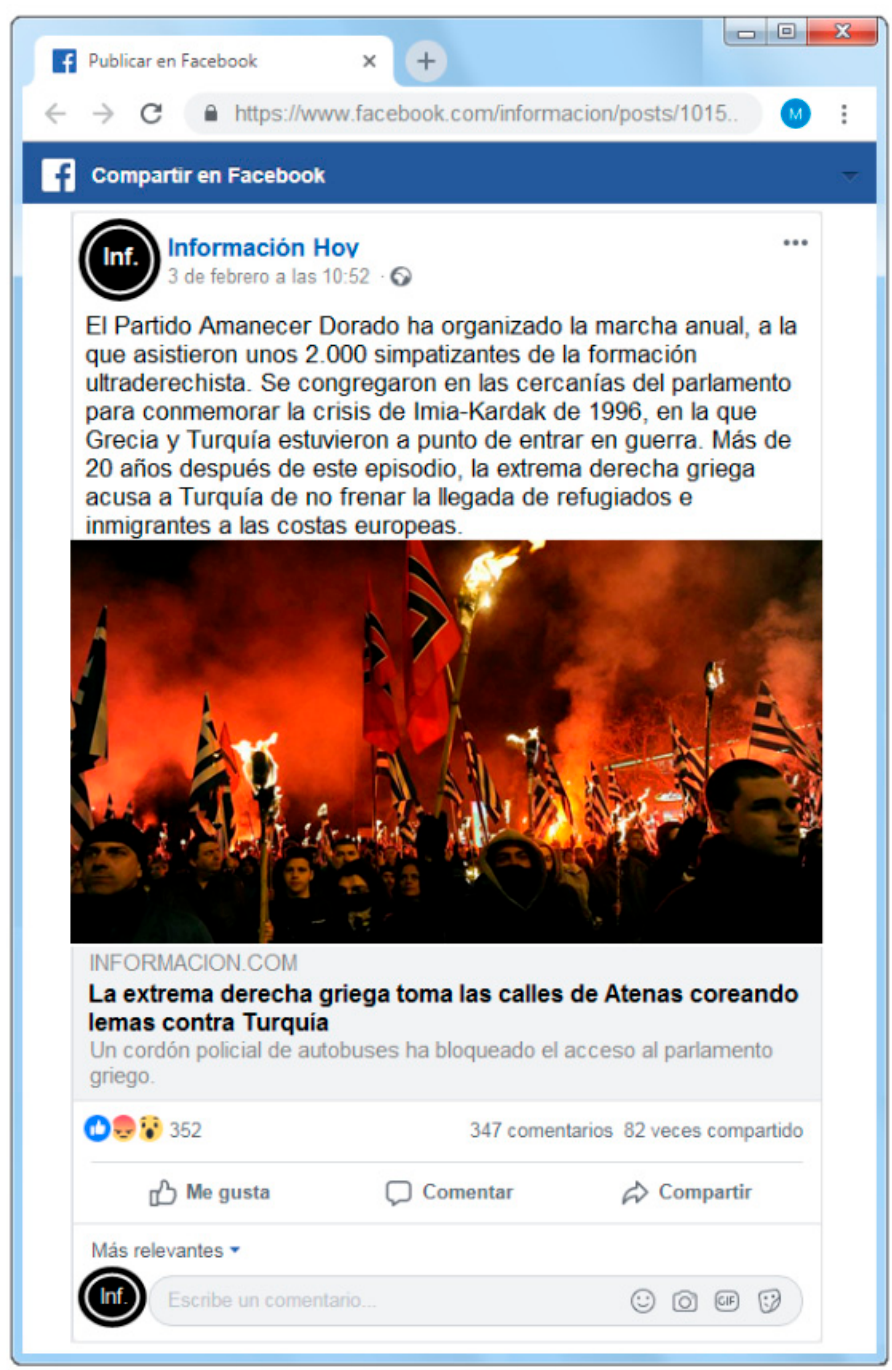
Figure A3. Sample of the news item on the far right in Facebook format.